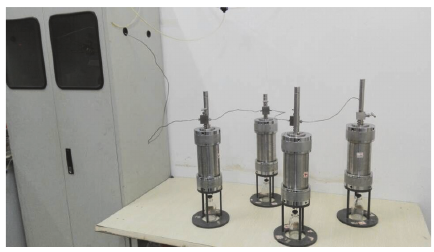
Figure 4: The photograph of the squeezing device.